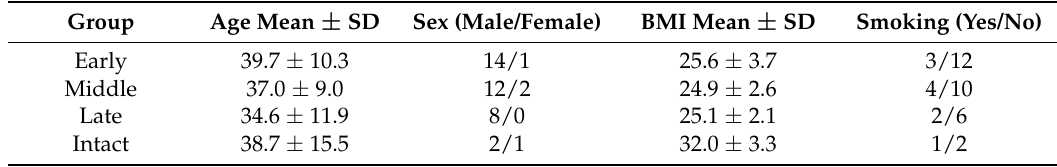
Table 1. Demographic